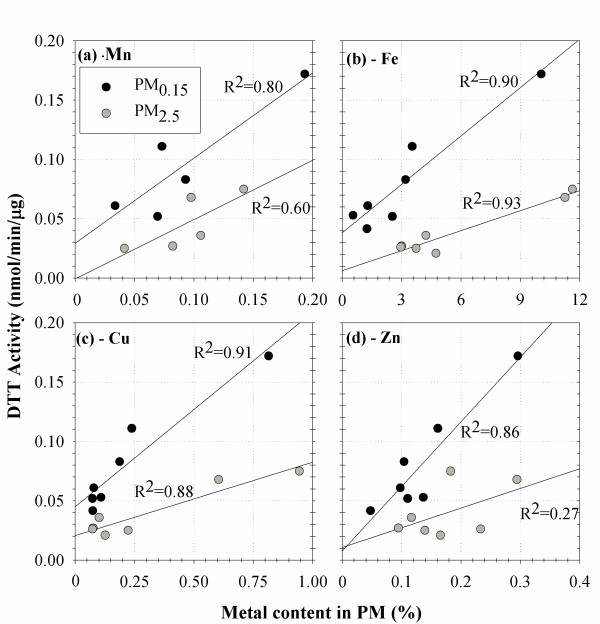
Correlation of DTT activity with different transition metals. Particulate samples are distinguished in two different particle size fractions (PM0.15 and PM2.5). The four panels show the correlation of the DTT activity of two different PM size fractions (PM0.15 and PM2.5) with (a) Mn, (b) Fe, (c) Cu, (d) Zn, respectively. These graphs show that despite the DTT activity of PM samples is not correlated with transition metals in the pooled samples of different size ranges (Table 2) there is a strong correlation with some metals within the two particle size fractions. This may probably be an artifact of the high correlation of metals and PAHs in these samples.